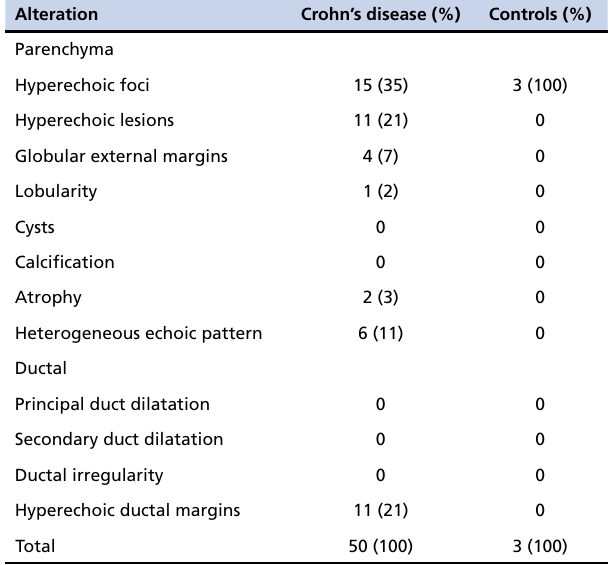
Table 3 – Endoscopic ultrasound findings of parenchymatous and ductal